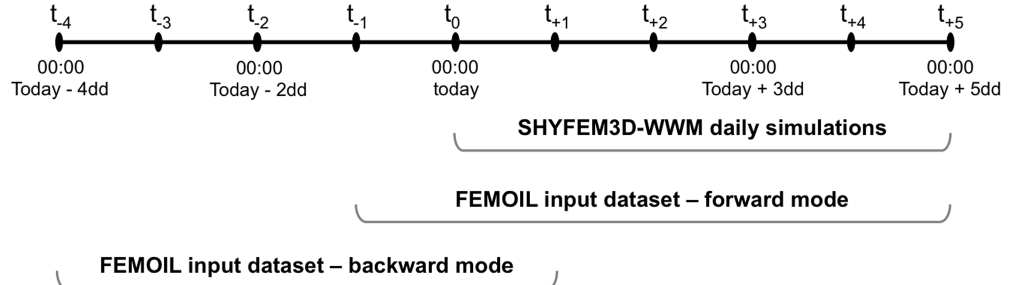
Fig. 3. The BOOM forecasting